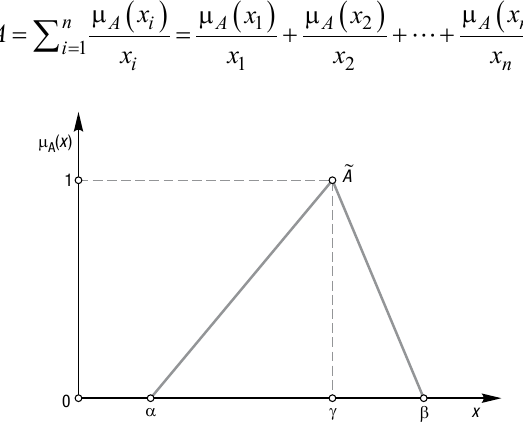
Fig. 3. Triangular membership